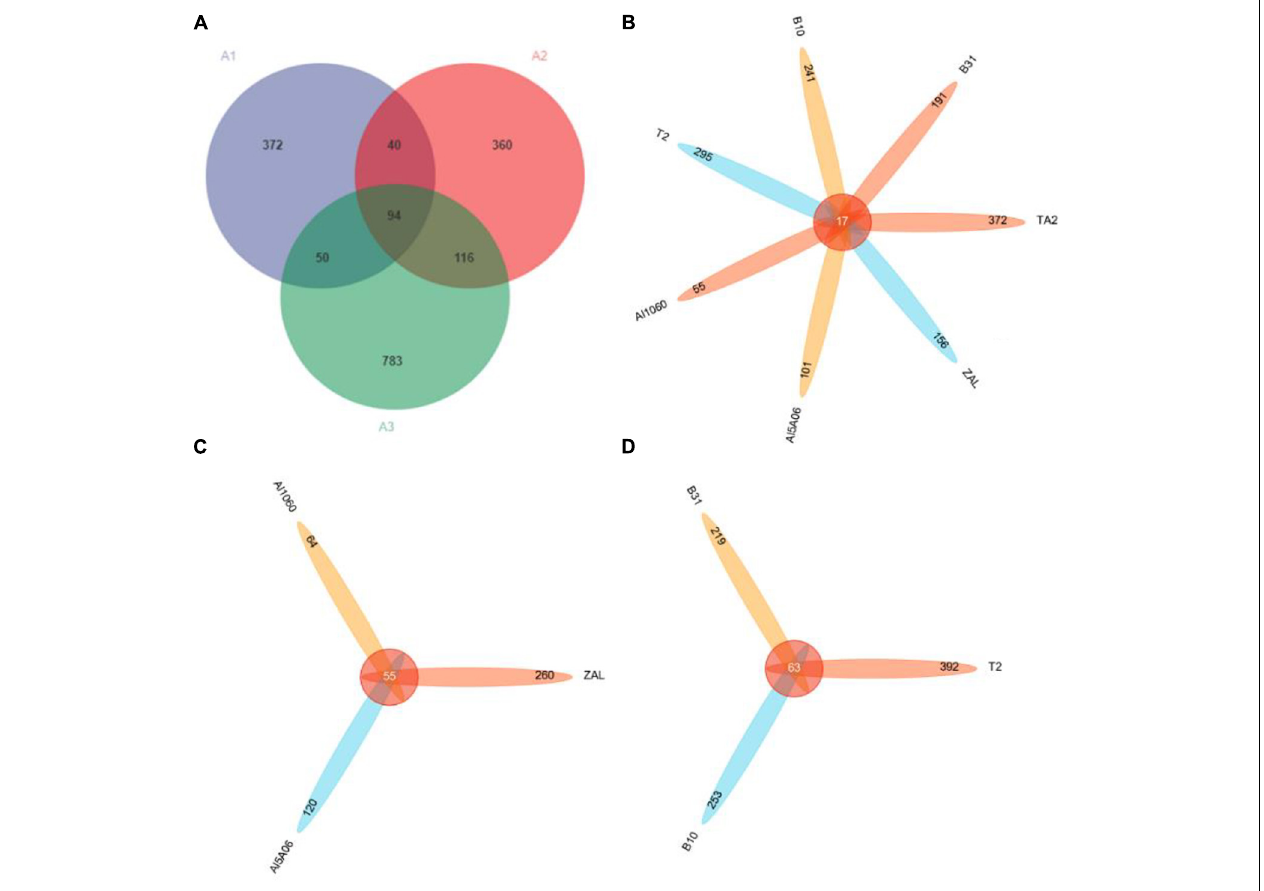
FIGURE 2 | Venn diagrams of seven samples in Yap Trench based on 16S rRNA gene sequencing at a distance of 0.03. (A) Diagram of all samples at group level, (B) diagram of all samples at sample level, (C) diagram of aluminum alloys, (D) diagram of copper alloys (TA2, ZAL, Al5A06, Al1060, T2, B10, and B30 represented the biofilms collected from the corresponding alloy surfaces. A1 group referred to the titanium sample TA2; A2 group referred to the aluminum alloy samples ZAL, Al5A06, and Al1060; and A3 group referred to the copper alloy samples T2, B10, and B30).